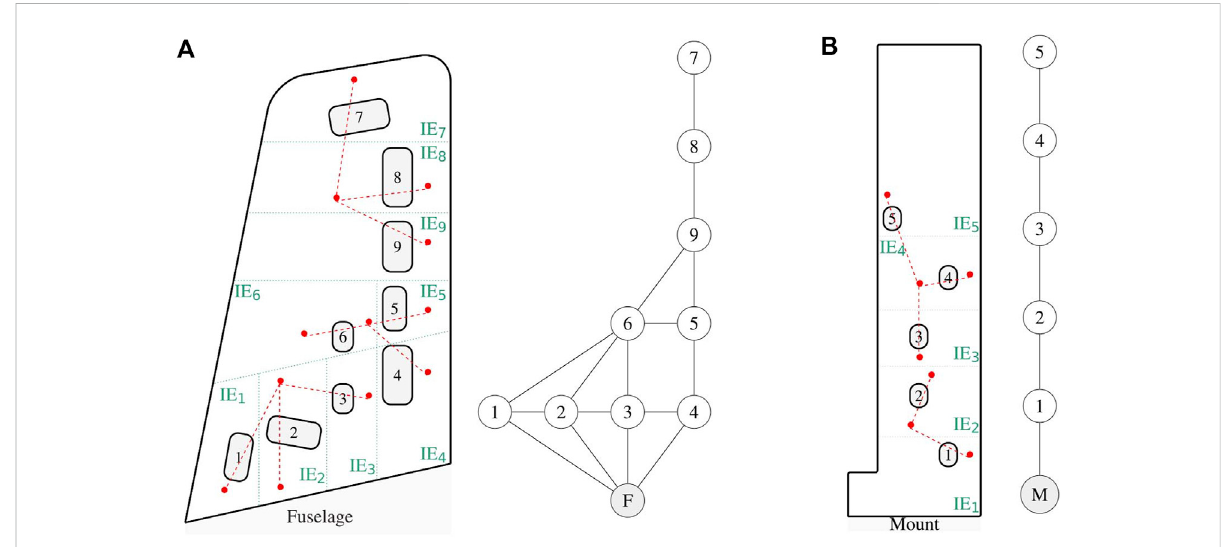
FIGURE 1 Schematic (A) of the Gnat aircraft wing (not to scale) and associated irreducible element model (left) with its corresponding attributed graph (right). Schematic (B) of the Piper Tomahawk aircraft wing (not to scale) and associated irreducible element model (left) with its corresponding attributed graph (right).